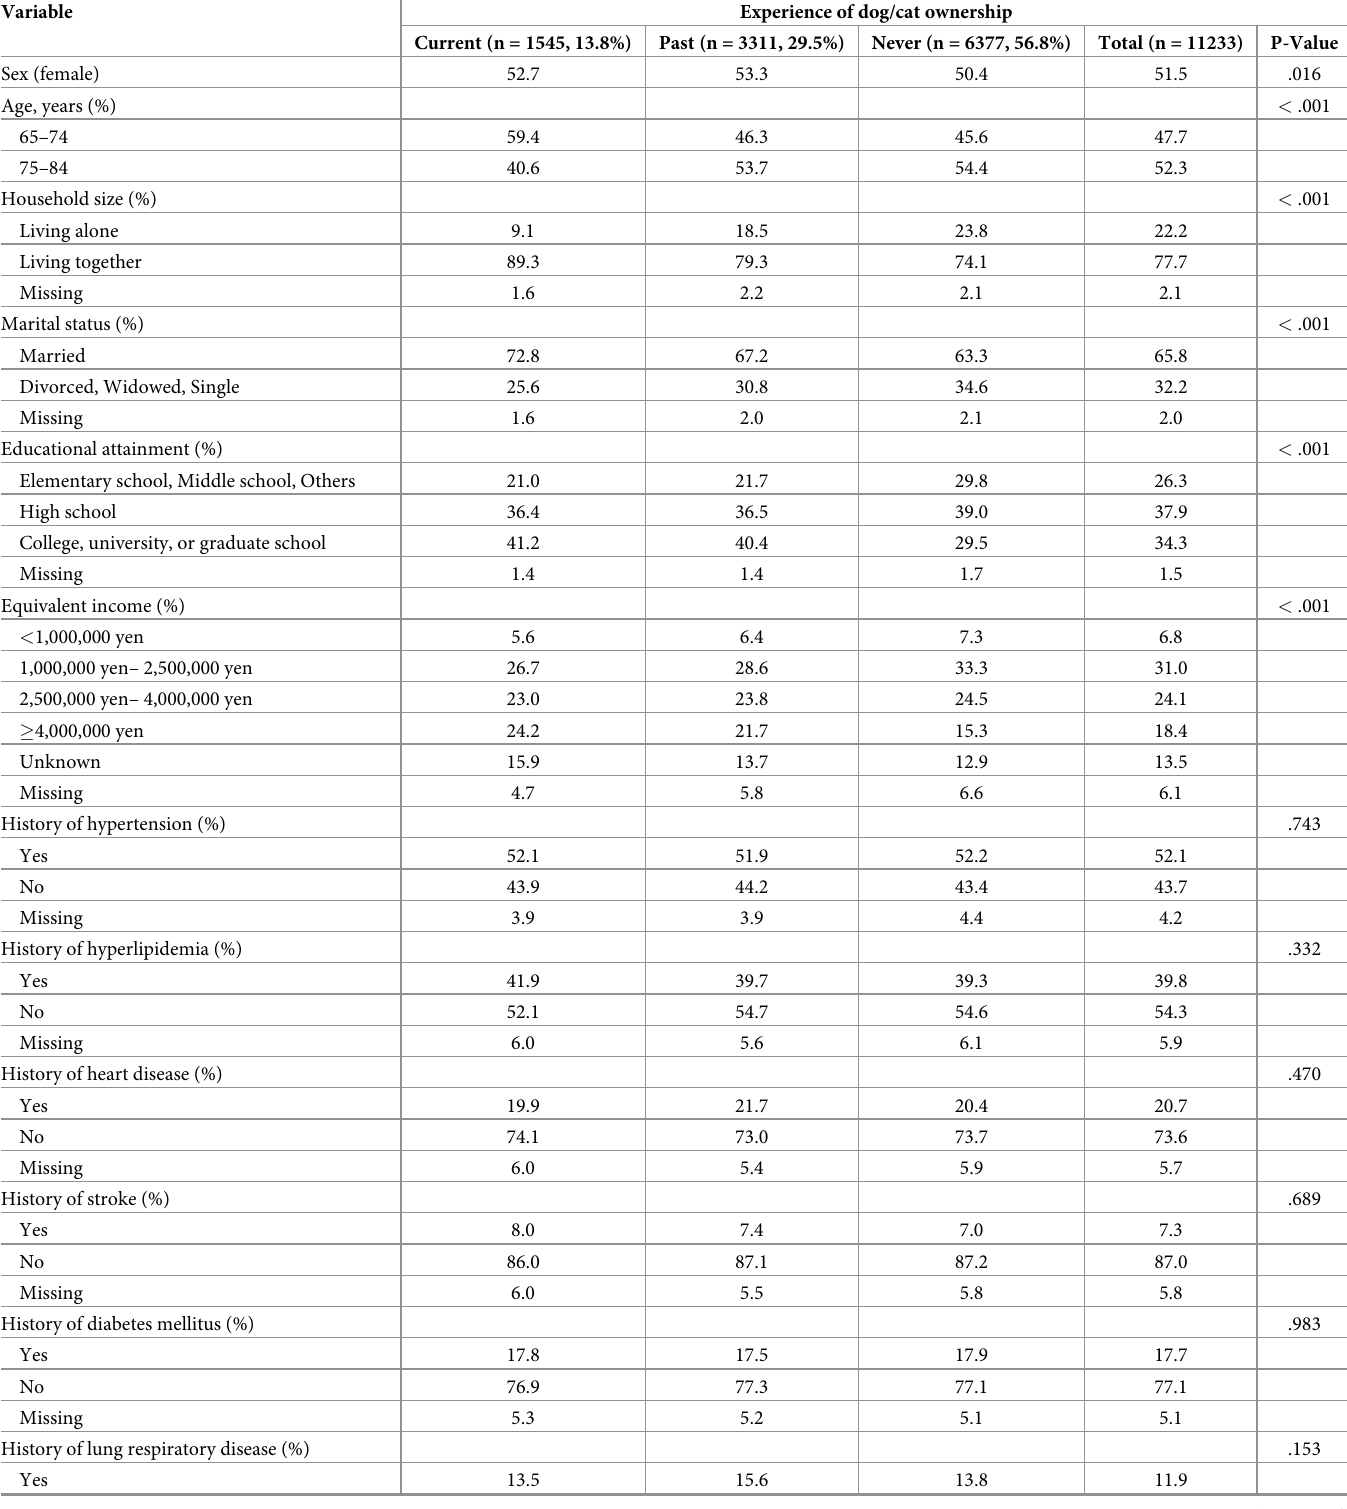
Table 1. Baseline demographic and health characteristics among community-dwelling older Japanese with and without experience of dog/cat